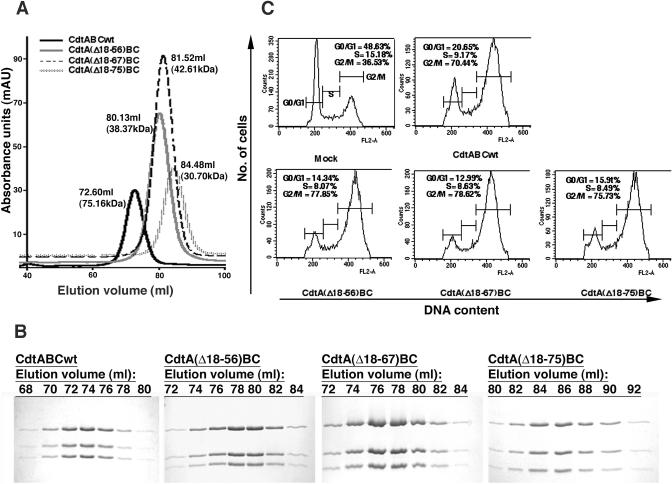
Effects of N-Terminal Deletions of CdtA on Holotoxin Integrity and Toxicity(A) Size exclusion chromatography profile of CDT holotoxin containing wild-type or deletion mutants of CdtA, wild-type CdtB, and myc-tagged CdtC. Following cation-exchange chromatography, 2-ml samples were injected onto a Superdex 200 HiLoad 16/60 column and run at flow rate of 2 ml/min in 200 mM NaCl, 20 mM HEPES (pH 7.5), and 2.5 mM DTT on an ÄKTA FPLC. Fractions of 2 ml were collected. Calculated molecular weights of globular proteins eluting at the same elution volumes are indicated in parentheses.(B) Peak fractions were analyzed by SDS-PAGE, and CDT subunits were visualized with Coomassie blue stain. A, CdtA; B, CdtB; C, CdtC; A*, deletion mutants of CdtA.(C) Cell cycle analysis of HeLa cells exposed to 1 ng/ml concentration of the wild-type or mutant holotoxin for 3 hr at 37 °C, 5% CO2. Cells were processed 48 hr after holotoxin treatment, and DNA content was measured by flow cytometry. The calculated percentages of cells in G0/G1, S, and G2/M are shown.